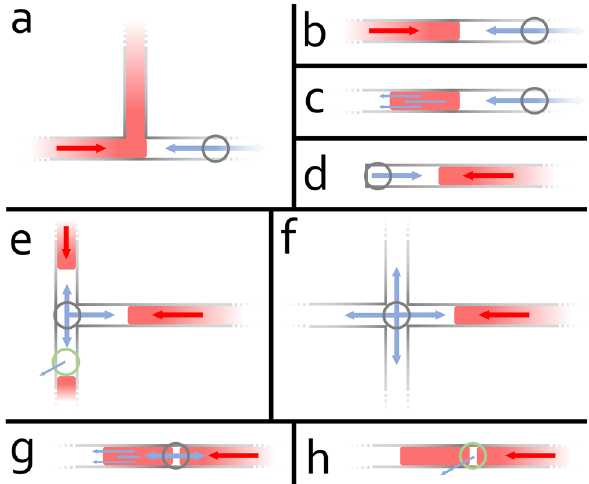
Figure 2. Illustration of possible usages of the presented active flow control mechanism on single-layer microfluidic chips. The red rectangle shape represents fluid in a channel. The red arrow represents where the fluid is coming from, and the blue arrow represents the added pressure and its direction. The grey circle represents the inlet of pressure, and the green circle the outlet. ( a ) A counter-pressure blocks the incoming fluid flow and only allows the fluid to flow to one channel (direction). ( b ) A counter-pressure blocks the incoming fluid flow (simple blockage). ( c ) The added pressure is pushing a segment of fluid content (transportation). ( d ) A counter-pressure slows down the incoming fluid flow in a dead-end channel (slow down). ( e ) A counter- pressure blocks the incoming fluid flows and stops the convergence of both fluids. An appropriate pressure outlet keeps other content in that channel from being affected. ( f ) Another example of fluid blockage in an intersecting channel. ( g ) A fluid sample flows through the pressure inlet point, and a counter-pressure is then added to block the fluid flow from further flowing and splits the fluid flow. A new free fluid segment is built (cut off). ( h ) The pressure outlet allows the release of air and lets the segment of fluid (re)merge with the main flow (merge).